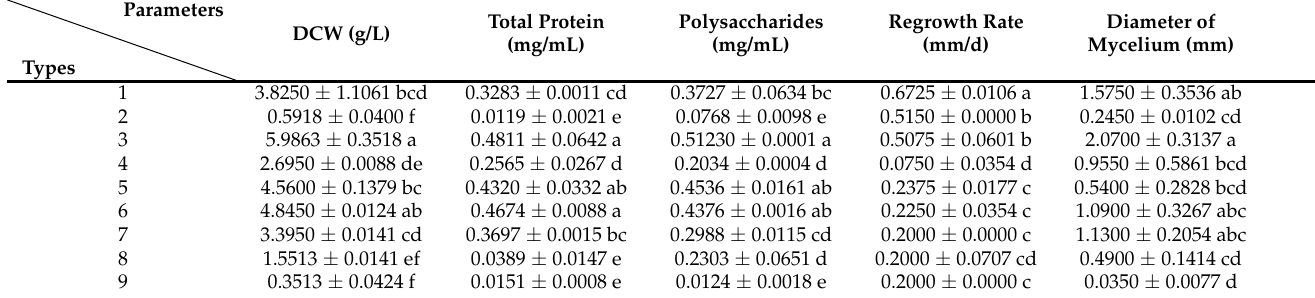
Table 6. Comparison of physiological and biochemical indexes of P. eryngii -3 by the nine